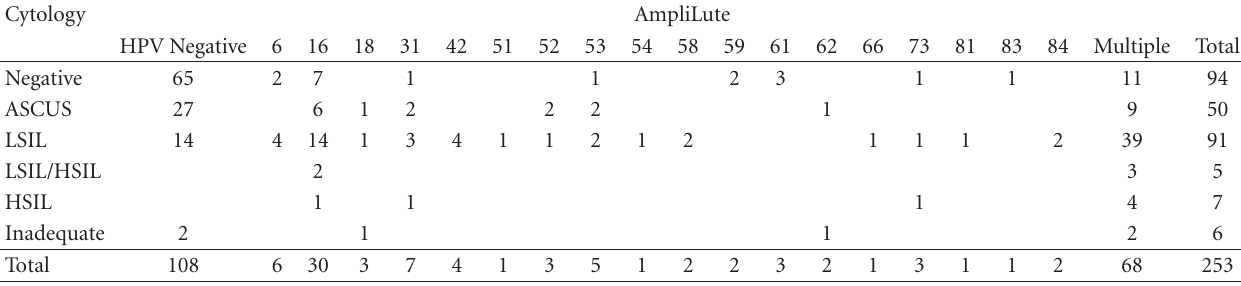
Table 4: Distribution of HPV types (in single infections) detected by AmpliLute method against cytological diagnosis. Cytology AmpliLute